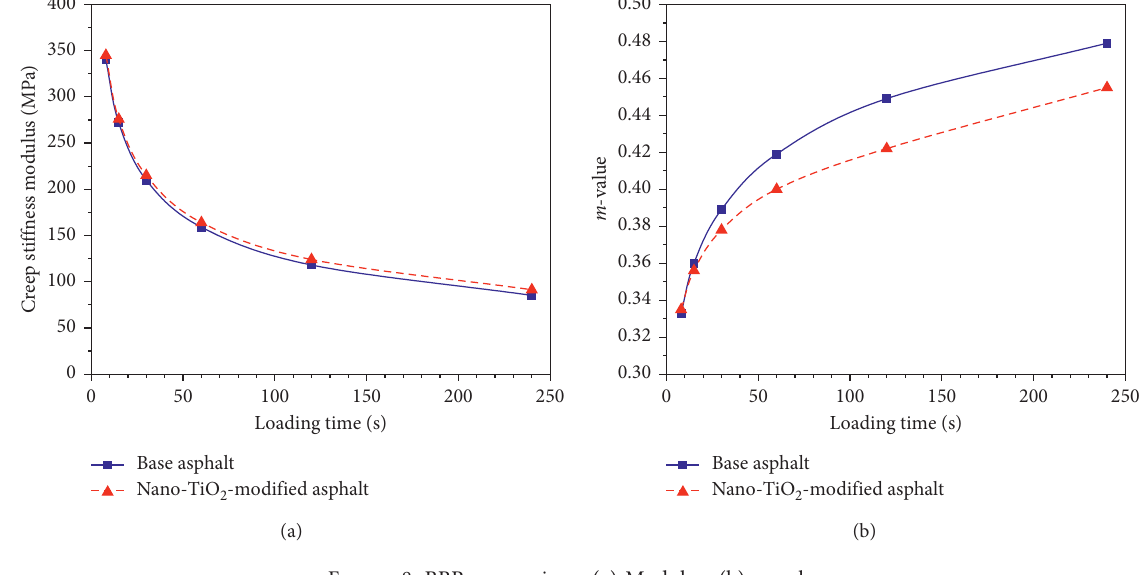
Figure 8: BBR comparison. (a) Modulus. (b) m